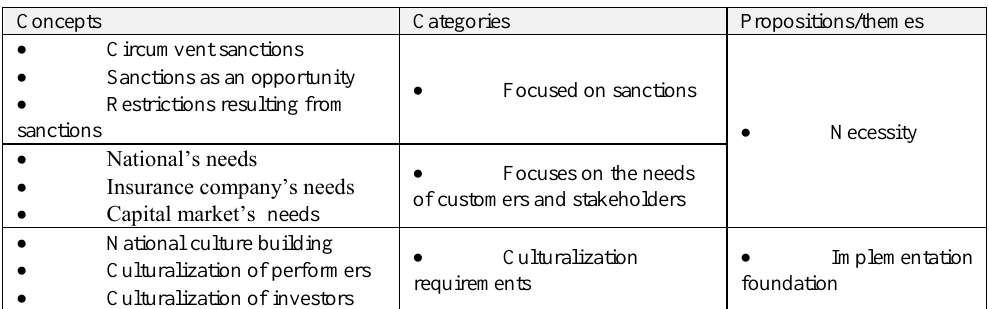
Figure 11- Interviewer Selection